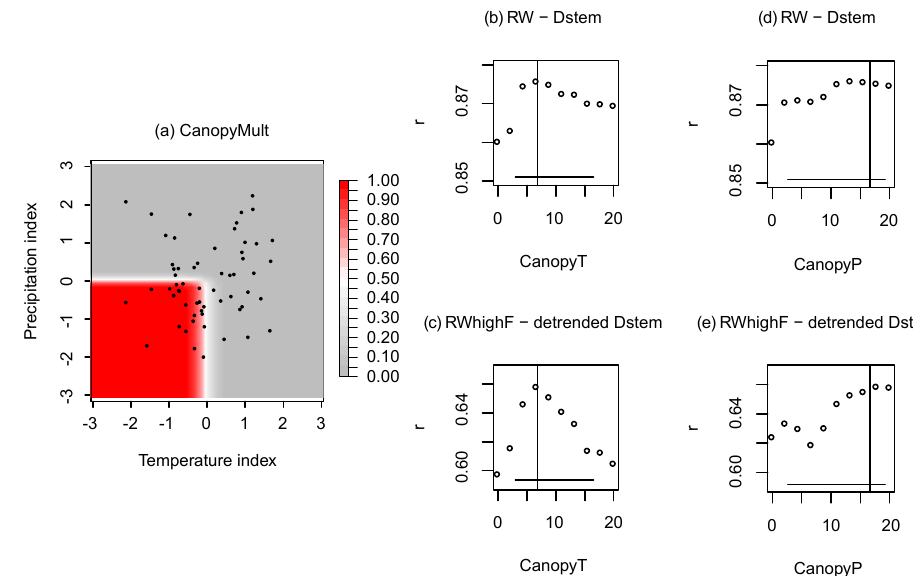
Figure 7. Temperature and precipitation dependence of CanopyMult ( a ; unitless multiplier; Eq. 4; CanopyT and CanopyP are those of plausible block stem), which determines the yearly canopy potential amount of carbon. Previous-year mean July–August temperature indexes are on the x axis, and previous-year April precipitation indexes are on the y axis. Black dots are observed values in the central point of the region with ring width data. Panels (b–e) show how CanopyT and CanopyP (varying over their prior acceptable ranges) impact the correlations between simulated Dstem (gCm − 2 yr − 1 ) and observed ring width data (RW or RWhighF; unitless indexes), when all other parameters are fixed to the values of plausible block stem. The vertical lines are the selected values for plausible block stem, and the horizontal lines are the 90% confidence intervals based on the parameters’ posterior densities (Fig.